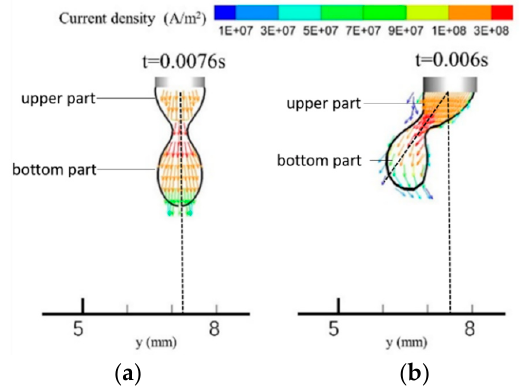
Figure 7. Current density distribution in the droplet: ( a ) MIG; ( b ) TIG-MIG.